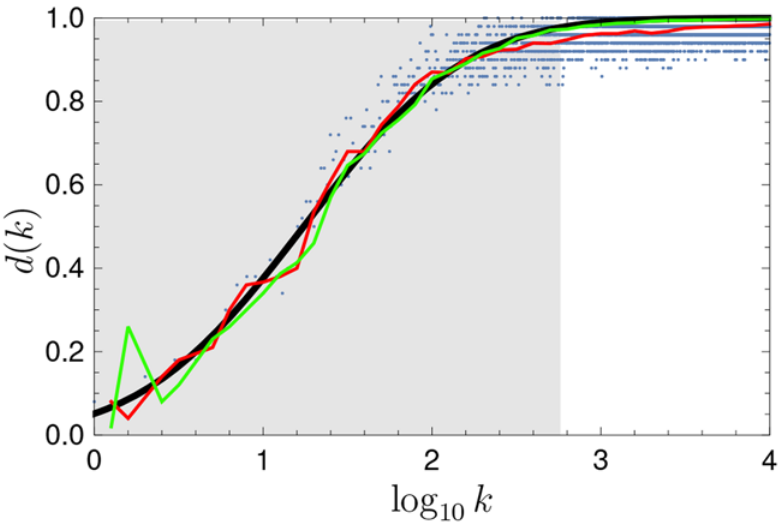
Fig 7. Rank diversity of male chess players obtained from the trimestral FIDE rankings from April, 2001 to May, 2012 ( Δ t = 50), considering the first 10,000 ranks. Blue dots show rank diversity, windowed in the red line. The black line shows the sigmoid fit with μ = 1.24 and σ = 0.76. The green line shows a simulation with ^ s ¼ 0 : 18 . Notice that there is no head as μ − 2 σ < 0. This is to be expected, as many players enter and leave the ranking during the years